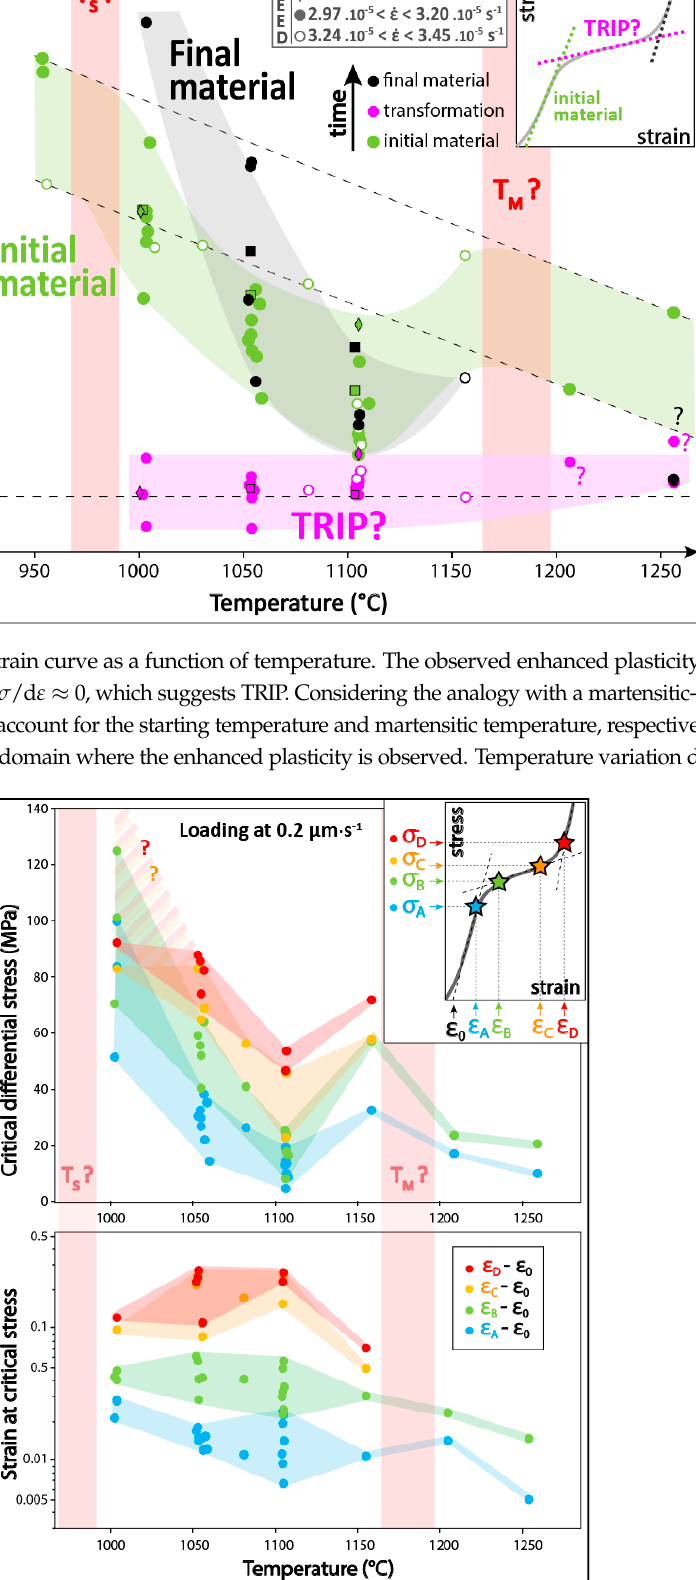
Figure 8. Critical differential stresses and associated strain. The “martensitic window”, between T S and T M , is defined in Figure 7.